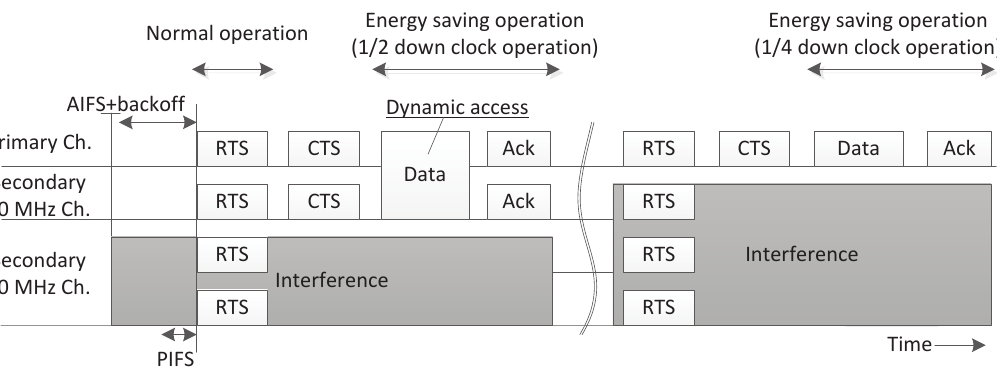
Figure 4. Dynamic energy saving operation; AIFS: arbitration interframe